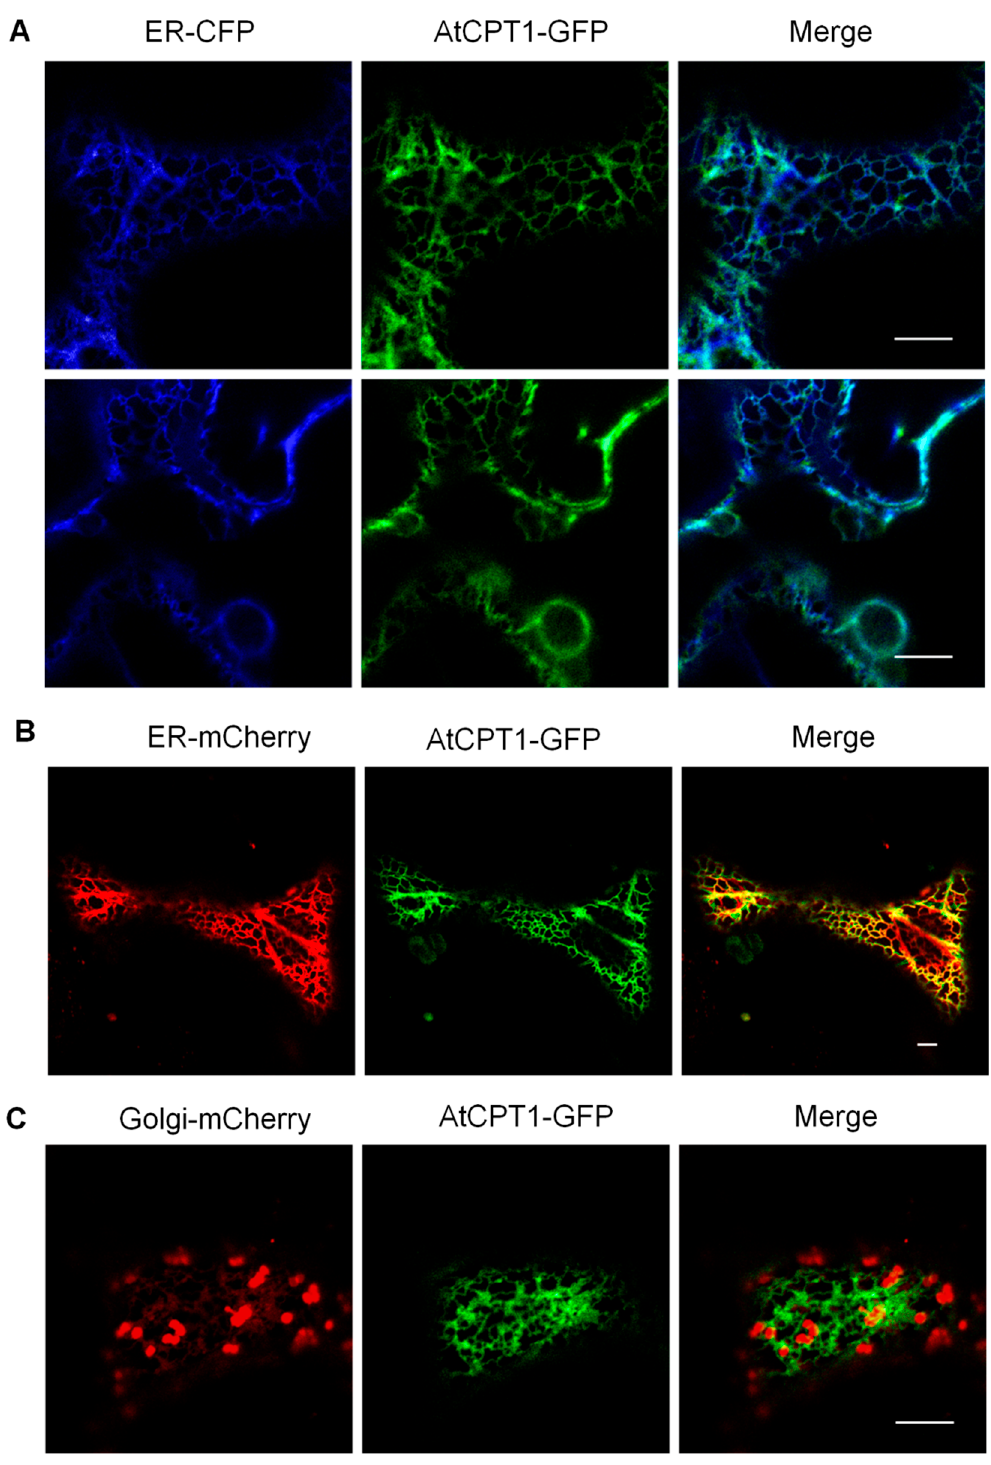
Figure 4. Subcellular localization of AtCPT1. Tobacco leaves transiently expressing AtCPT1 containing a C-terminal GFP-tag fused at the C-terminus to GFP. AtCPT1-GFP signal is co-localized mostly with the markers of the endoplasmic reticulum ( A , B ) while no co-localization with Golgi marker ( C ) is observed. P S35 :: AtCPT1 -GFP (green) and organelle markers ER-CFP ( A ), ER-mCherry ( B ) or Golgi-mCherry ( C ) were transiently expressed in N. benthamiana leaves by agroinfiltration. Scale bars = 10 µm. Representative pictures are shown.